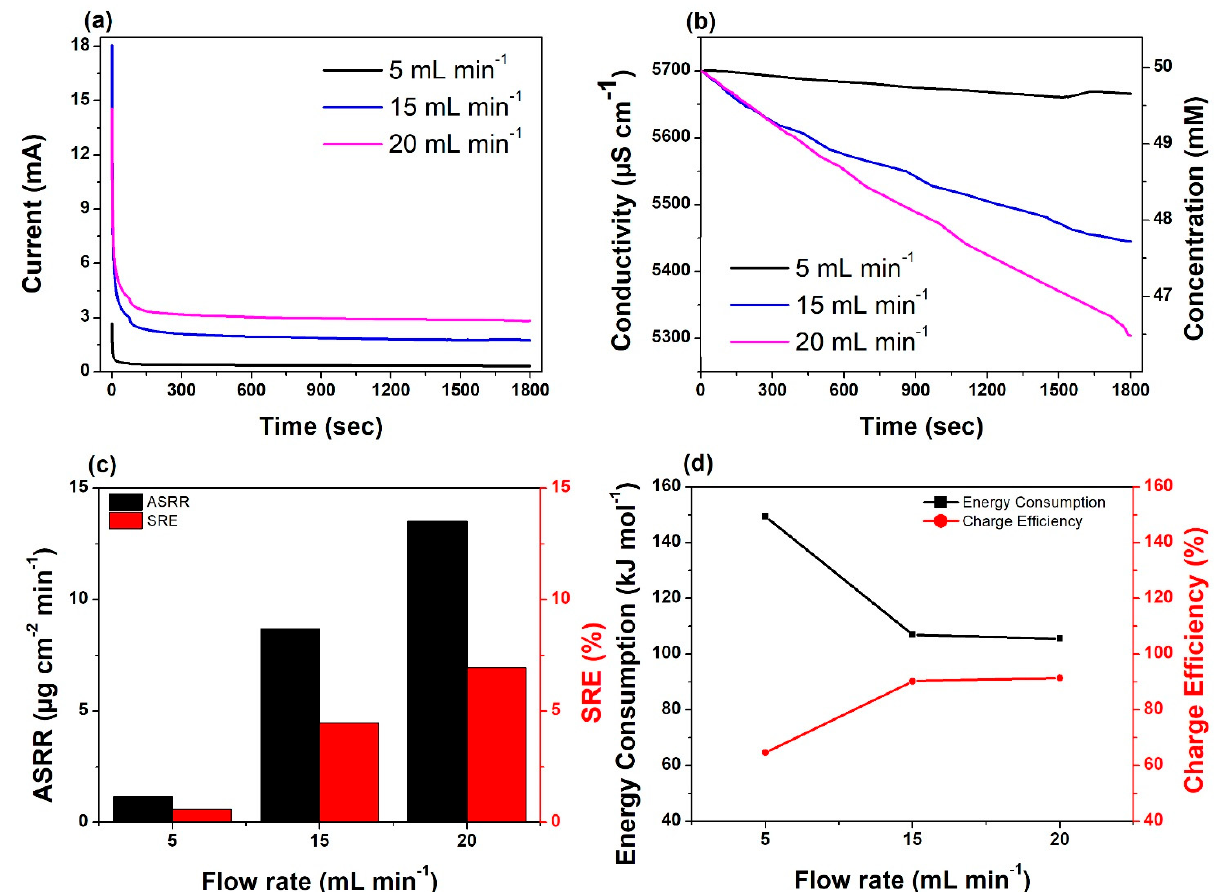
Figure 6. Effect of flow rate of the flow electrode cell voltage on the FCDI performance: ( a ) I-t curves with 1 V cell voltage, and the corresponding ( b ) conductivity and saline water concentration changes with time and ( c , d ) determined ASRR, SRE, EC and CE data.